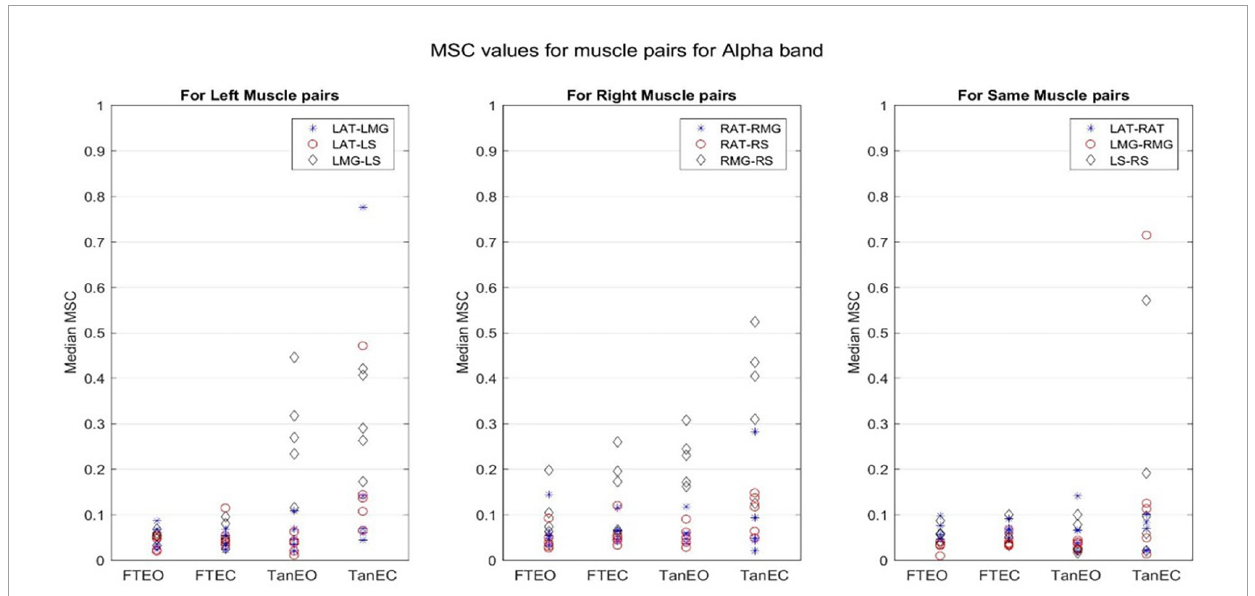
FIGURE6 Magnitude-squared-coherence plot for different muscle pairs under different standing conditions for alpha frequency band (8.2031–13.4766 Hz) for a single participant for all individual trials. The plot shows coherence between different muscle pairs for the most to least stable postural standing positions in the alpha band. It can be seen how coherence for different muscle pairs have increased, mainly in the right leg between RMG and RS on moving to lower frequency band.